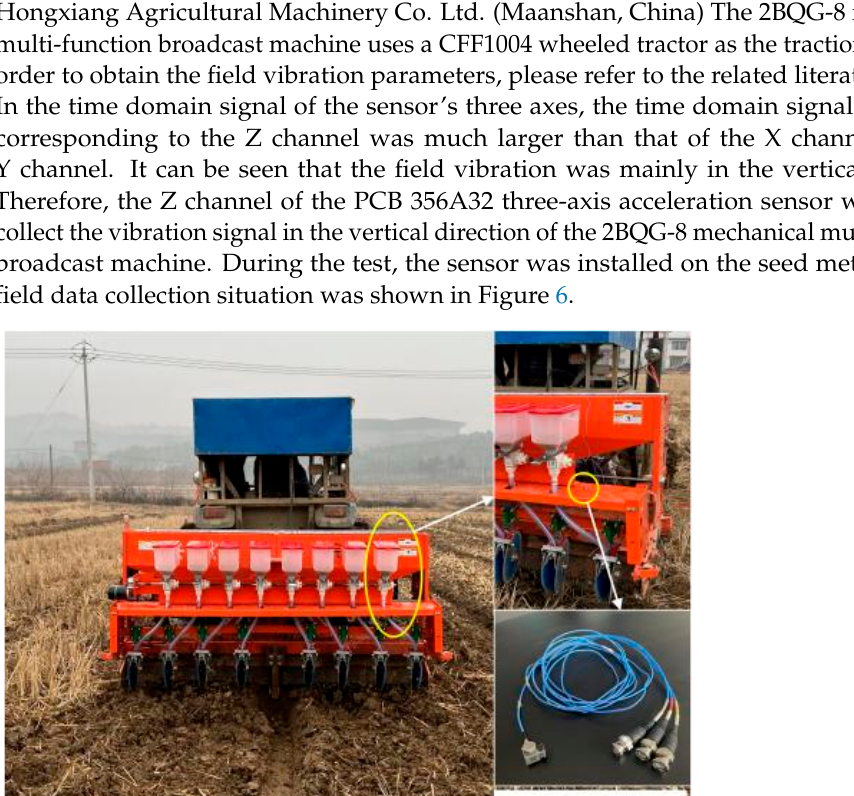
( b ) Figure 7. Vibration frequency analysis and parameter setting. ( a ) Vibration frequency domain dia- gram; ( b ) Test bench parameter setting. Figure 7a reveals that the predominant vibration frequency under these test condi- tions was 10 Hz. In other words, when the vibration frequency was 10 Hz, the highest acceleration was 9.60 m/s 2 , which corresponds to 0.97 g. According to the analysis of the real test conditions, the field terrain, the vibration of the tractor engine, and the seeding motor affected the primary frequency of the vibration. In order to meet the field condi- tions, the disturbance between populations was increased, and the efficiency of seed fill- ing was enhanced; the relationship between the vibration frequency of the actual field planter and the unilateral amplitude was determined, and the unilateral amplitude reached a maximum within the vibration frequency range of 0~10 Hz. As the frequency continued to climb, the acceleration of the vibration decreased. The maximum vibration frequency during this test’s sampling interval was 10 Hz. According to the study, the vi- bration frequency of 0~10 Hz can be utilized to replicate the maximum acceleration during field vibration in order to validate the seed metering equipment. Adaptability set the vi- bration frequency parameter interval of the bench test to 0~10 Hz, taking three gradients